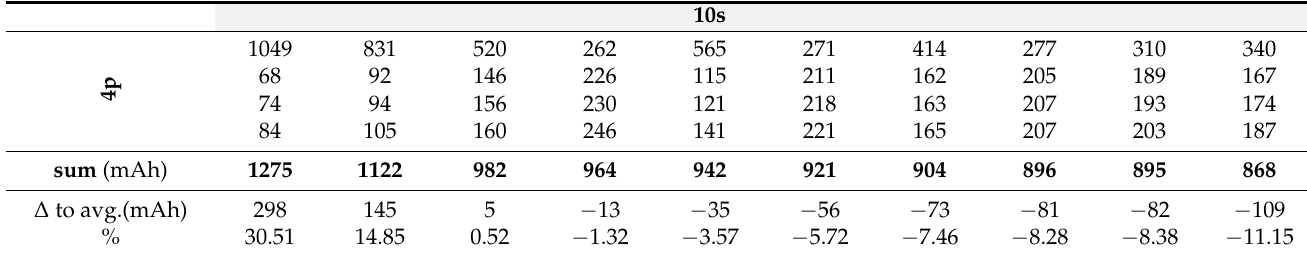
Table 4. Optimal layout of pack compound in 4p10s configuration arranged from the existing cells regarding cell capacities (mAh).